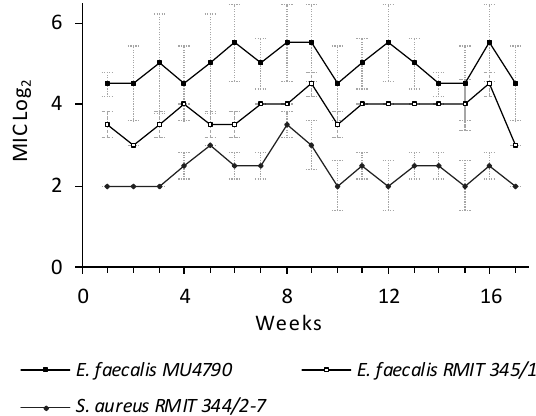
Figure 6. Weekly (W 1 –W 16 ) geomean MIC of VRE and MRSA. Strains, serially cultured for 16 weeks in CAMHB with NPBD, subculture to fresh dilution sets, W 1 to W 15 , and serial passage in CAMHB to W 16–17 . MIC/MBC W 0 and W 17 were determined by broth microdilution ([28,29], Table S8, Table S9). Inoculum density W 1 to W 15 varied <1 log 10. Assays were repeated twice. MBC ≤ 2 × MIC. 2.5% DMSO. Weekly inocula of 1–5 ×10 5 cfu/mL standardized and verified by viable count.